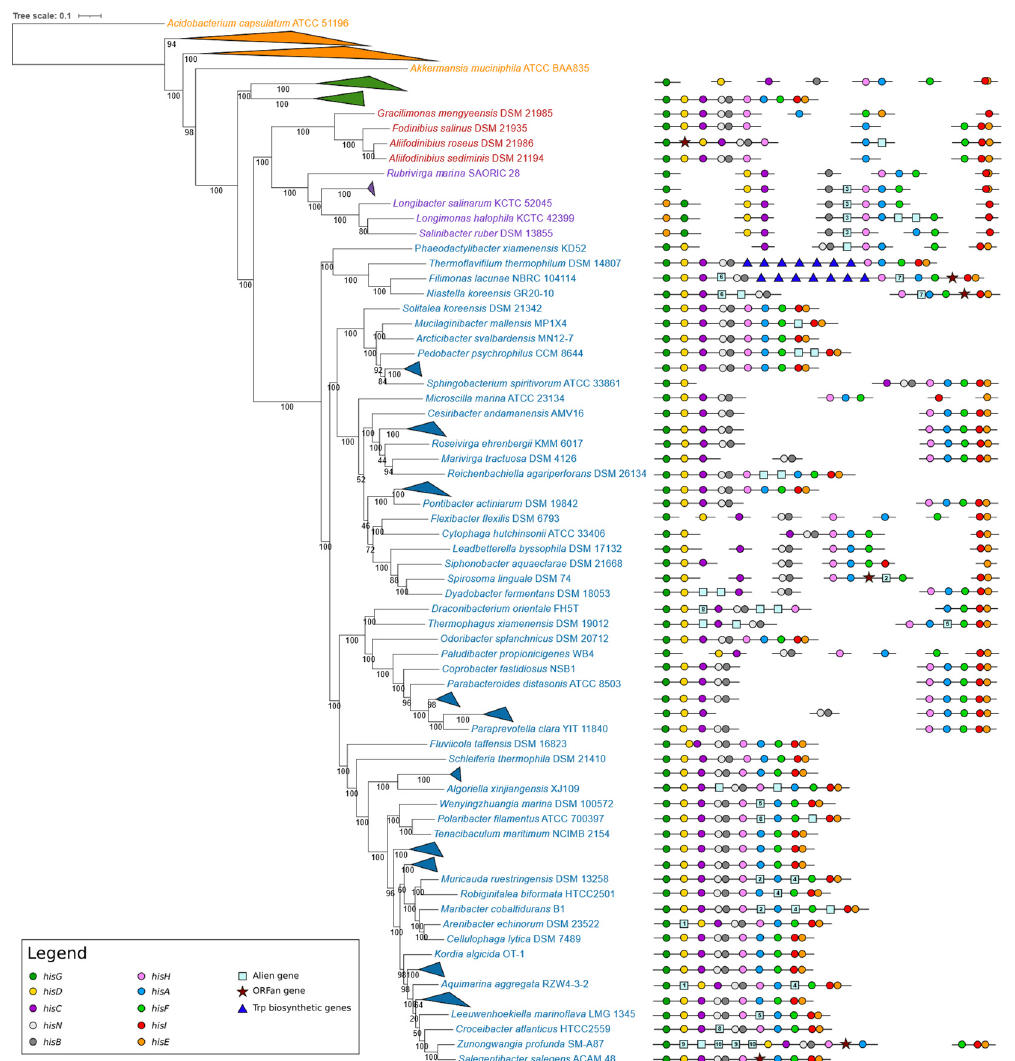
Figure 2. Phylogenetic tree based on the concatenation of 182 conserved proteins of the 91 superphylum organisms and 17 outgroups. After the multialignment trimming, 47,919 positions have been considered for the phylogenetic tree construction. Organisms reported in orange are the outgroups, those in blue are Bacteroidetes, those in green are Chlorobi, those in red are Balneolota, and those in violet are Rhodothermota. Genomic organization of his genes is represented on the right side of the figure. The outgroups and those organisms belonging to the same taxonomic group sharing the same genomic organization of his genes have been collapsed (the entire phylogenetic tree is available in Supplementary File S21, Figure S2). Numbers within the alien gene icons represent groups of proteins with a significant BLASTp E-value (Table S3, Supplementary File S1). Information about organisms’ growth temperature range is reported next to organisms’ names in the entire phylogenetic tree available in Supplementary File S21, Figure